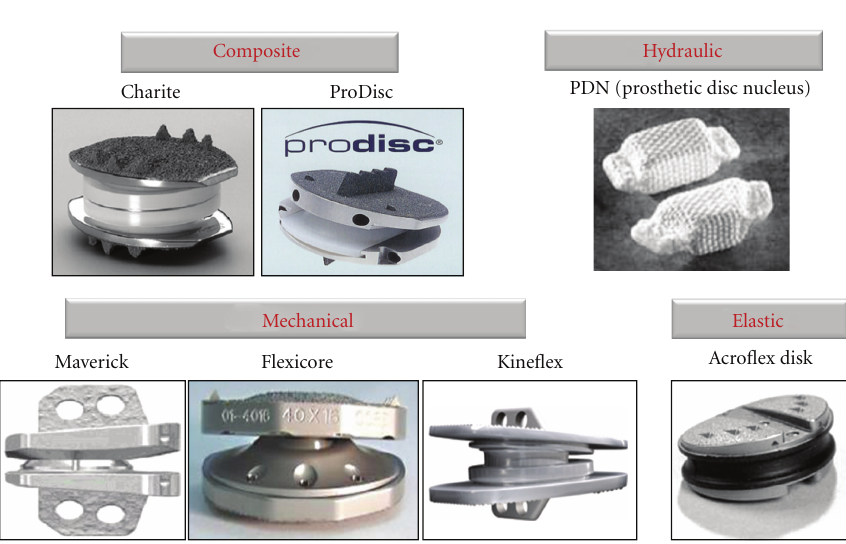
Figure 7: Di ff erent lumbar artificial disc concepts: Composite (Charit´e, Prodisc), Hydraulic (PDN), Mechanical (Maverick, Flexicore, Kineflex), and Elastic (Acroflex)